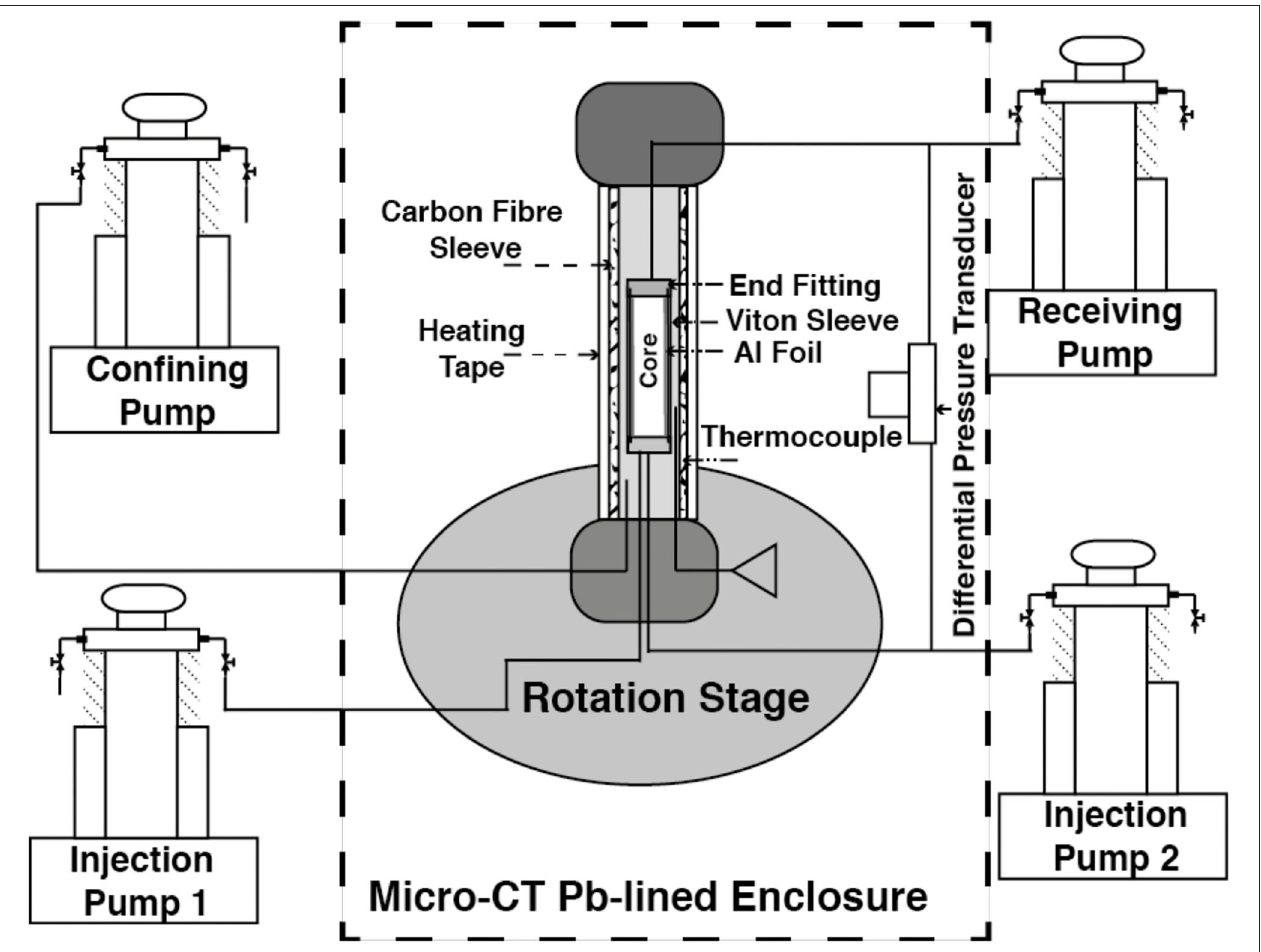
FIGURE 9 | The experimental apparatus consists of the injection, receiving, and confining pumps outside the micro-CT, with a core holder and differential transducer on the rotation stage inside the micro-CT lead-lined enclosure. The core holder is made of carbon fiber and is equipped with thermocouples and heating wrap. The core is wrapped in aluminum foil to minimize gas exsolution and beam hardening artifacts. It is then placed inside a Viton sleeve which is attached to the end fittings supporting the two injection pumps and receiving